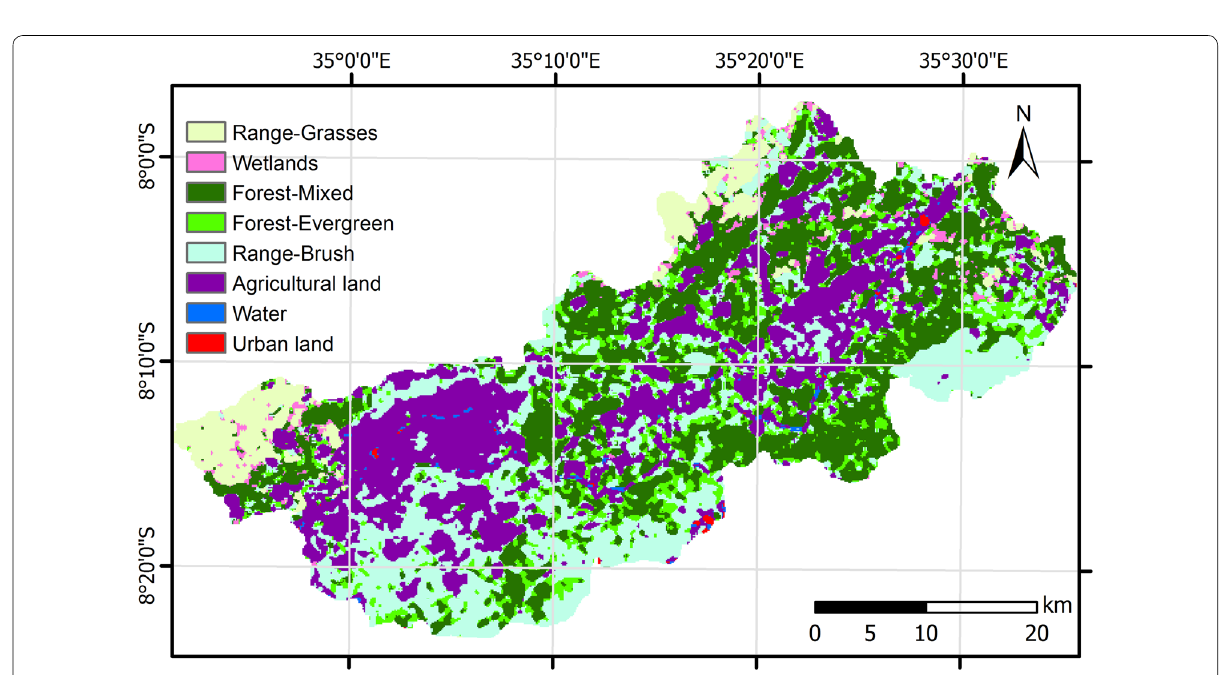
Fig. 6 Simulated land use/cover of 2020 of Ndembera river